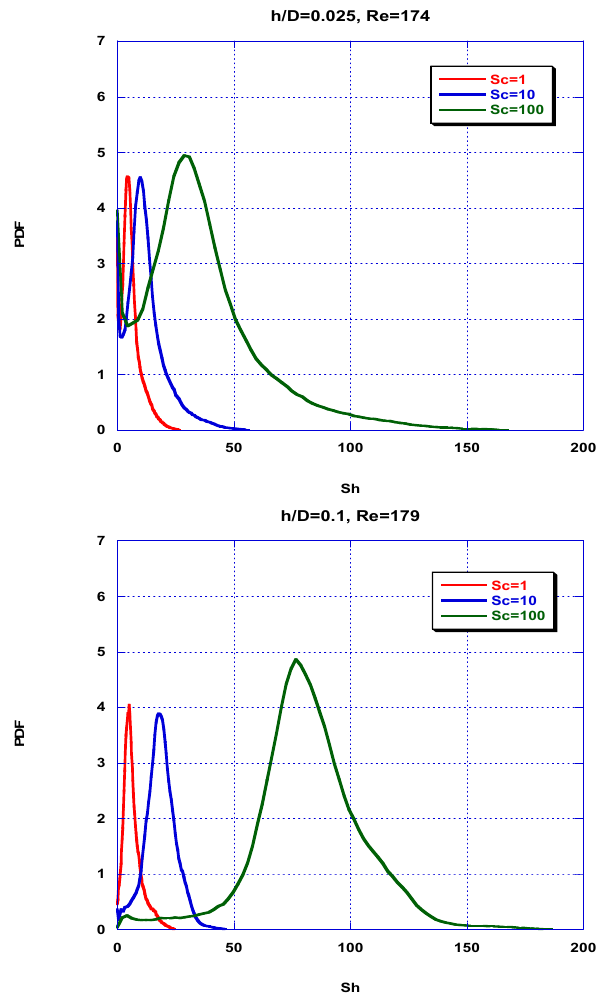
Figure 10. Probability density function of the time-averaged Sh number at the membrane surface for fouling-layer thickness ( h / D ) = 0.025 and 0.10 in the Sc number range 1–100. As in the case of pressure drop, a key objective of the mass-transfer simulations is to develop a sound correlation of Sh number with fouling-layer thickness, including the Re and Sc number dependencies. In Figure A4 (Appendix B), the measured space and time-average Sherwood number is plotted as a function of Sc number, for the range of Reynolds numbers and fouling-layer thickness examined in this work. These data sets, show that for all fouling-layer thicknesses tested, the Sc dependence of mean Sherwood number is practically constant, and equal to ~0.47.